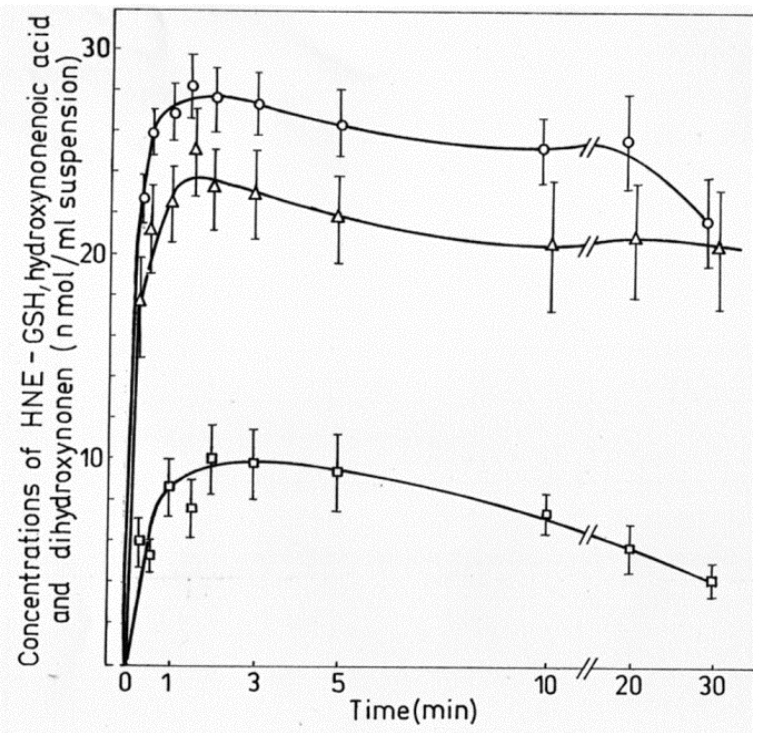
Figure 9. HNE metabolites. Formation of the so-called primary HNE metabolites HNA (∆), HNE-GSH (o) and DHN (□) in rat hepatocyte suspensions after loading the cell suspensions with 100 µM tritium-labelled HNE. The glutathione (GSH) adduct of HNE was